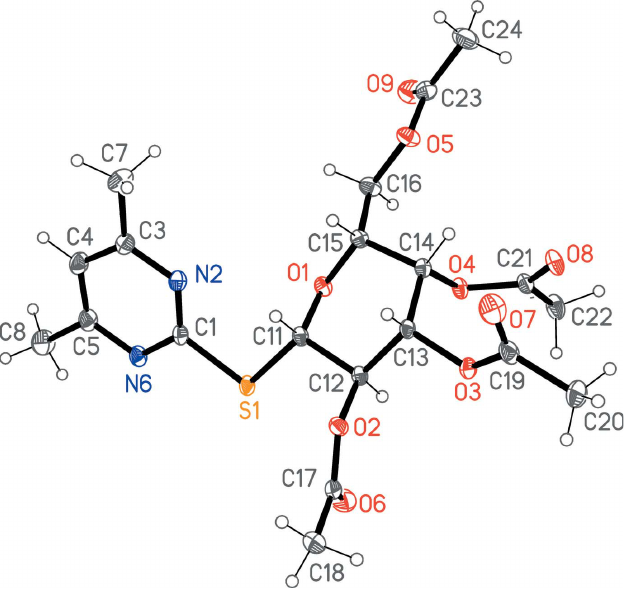
Figure 1 The molecular structure of the title compound, 4 , in the crystal. Displacement ellipsoids represent 50% probability